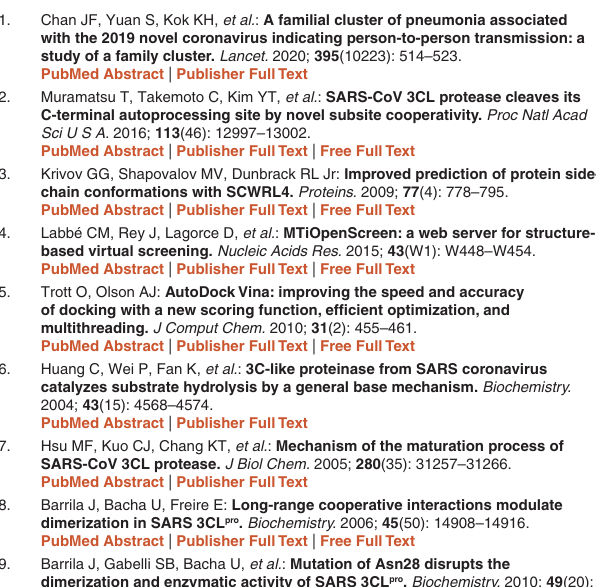
Fig S1.pptx (The structural model of the SARS-CoV-2 3CL pro protease).